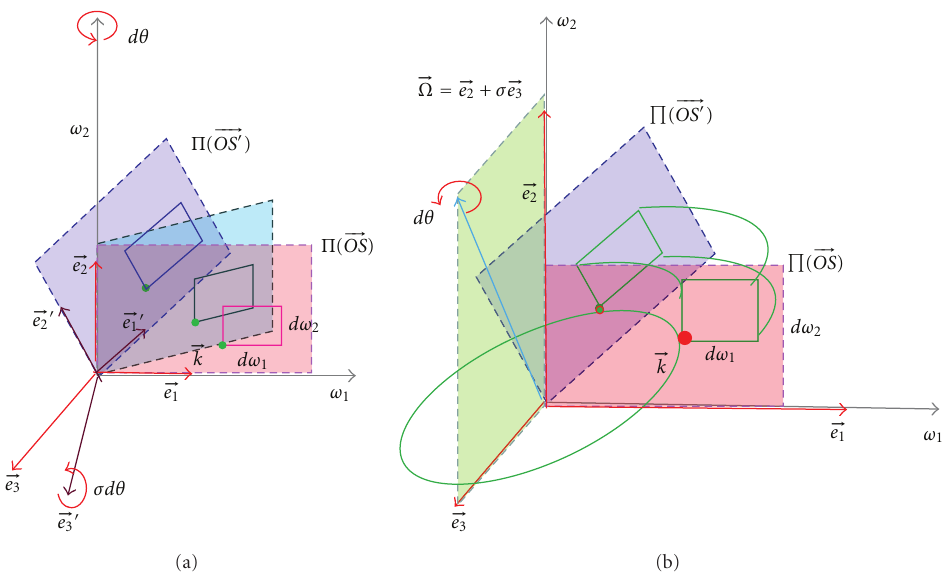
Figure 5: Di ff erential motion of the frequency plane. (a) Two decomposed rotations and (b) one combined rotation.